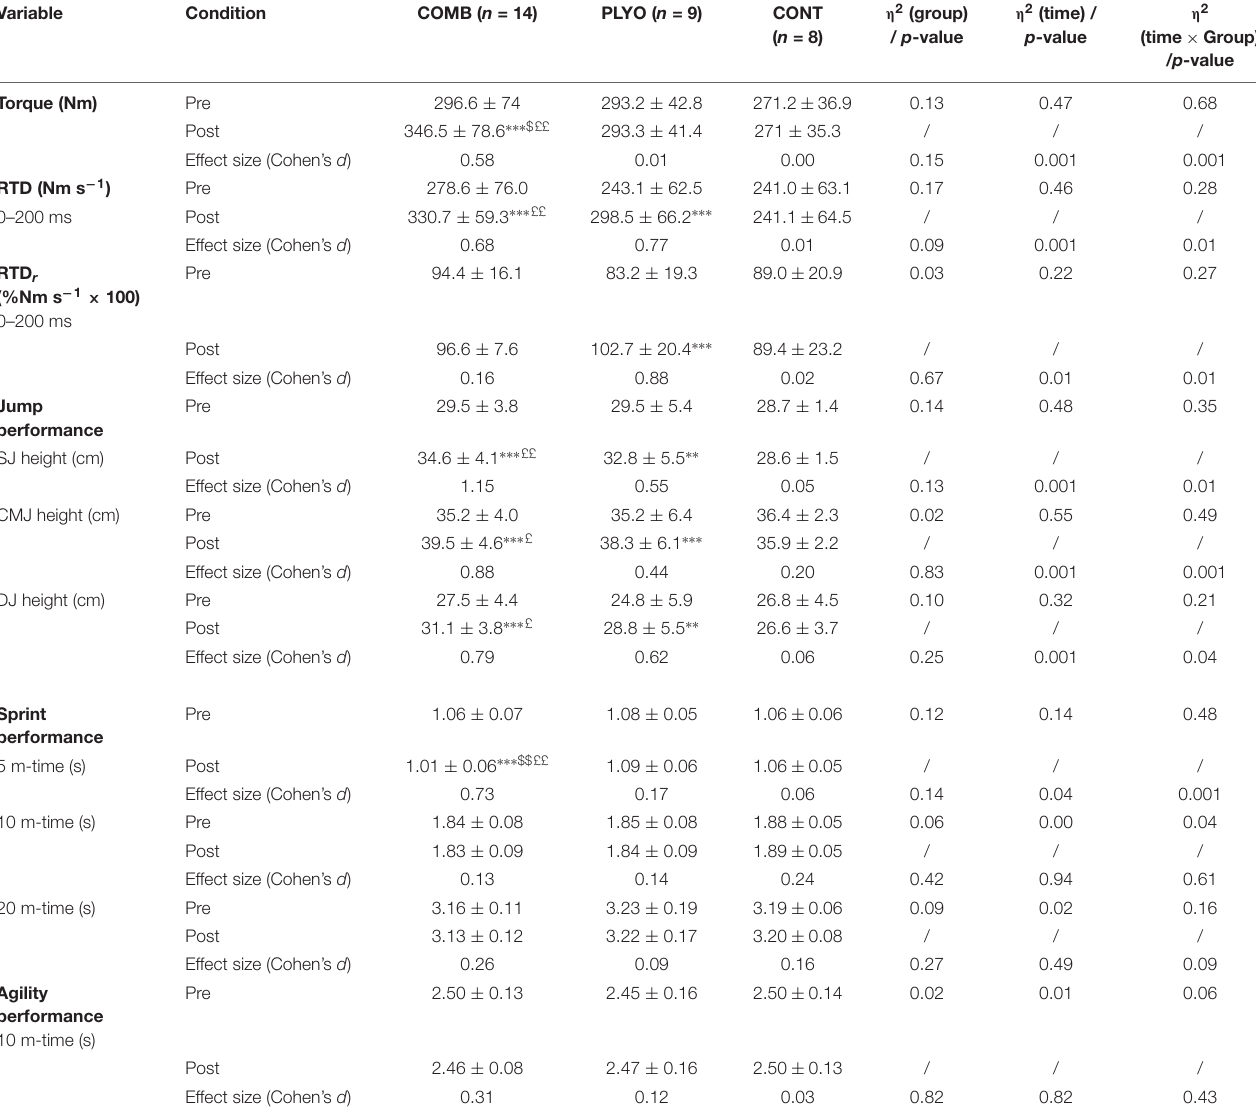
TABLE 3 | Pre- and post-test values of the measured variables.